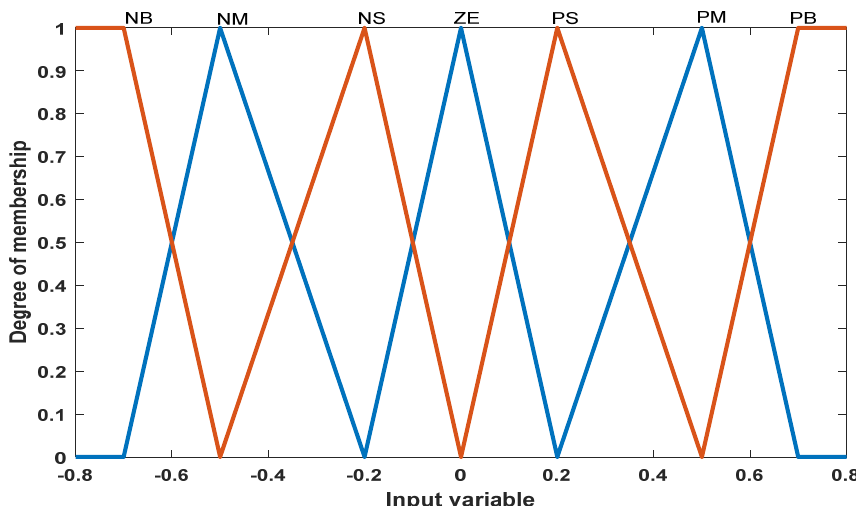
Figure 2. Input membership function for power.